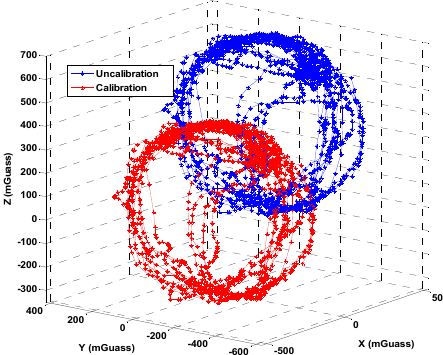
Figure 2. Magnetometer bias calibration.